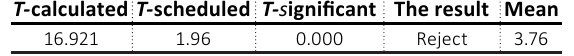
Table 7. Results related to the first sub-hypothesis